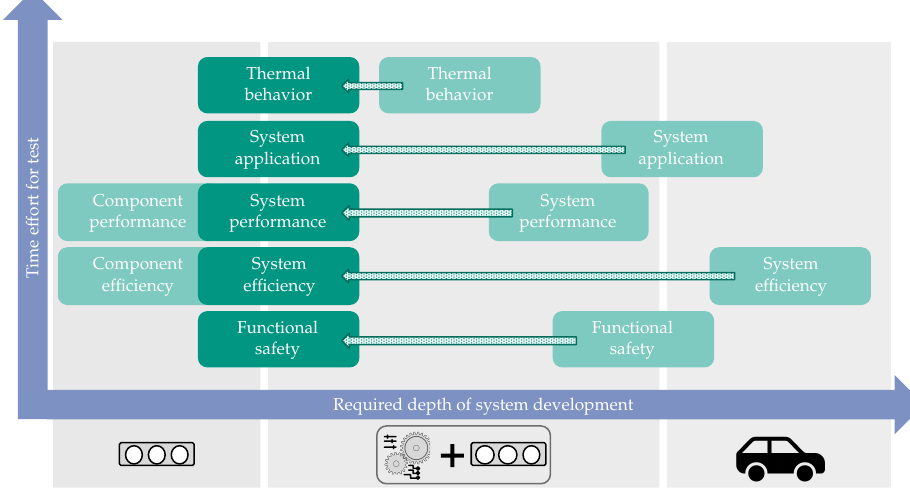
Figure 1. Visualization of test cases in vehicle development as a function of time, effort, and required system development